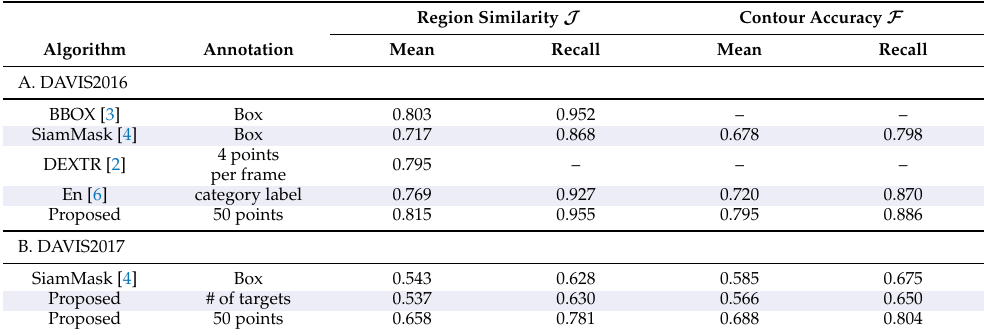
Table 9. Comparison of the proposed weakly supervised algorithm with the conventional weakly supervised algorithms on the validation sets in DAVIS2016 and DAVIS2017 according to annotation types: ‘# of targets’ denotes the number of target